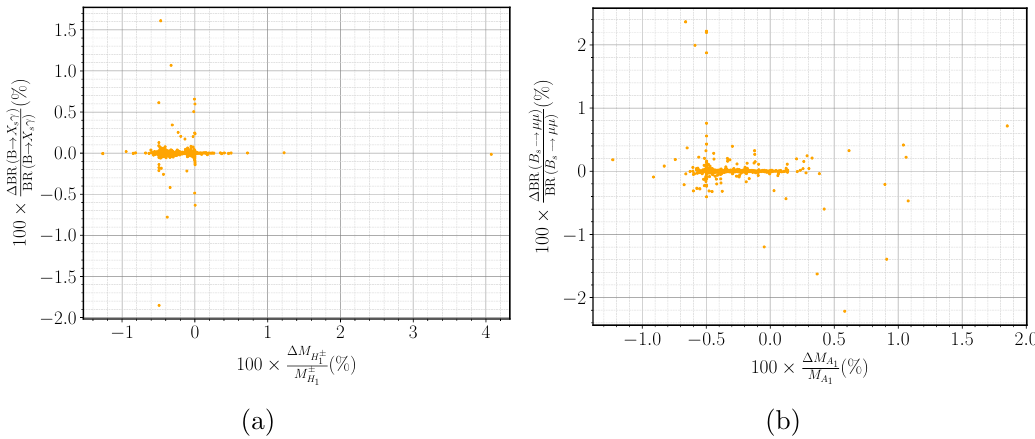
Figure 8 . Percentage of variation of the branching fractions (a) for B → X s γ decay and (b) for B s → µ + µ − decay as functions of the percentage of variation in scalar boson masses. In the set of input parameters for which all experimental and theoretical constraints were satisfied, each of the soft breaking parameters were smeared by less than 1% around their initial values, keeping the Yukawa couplings and mixing angles